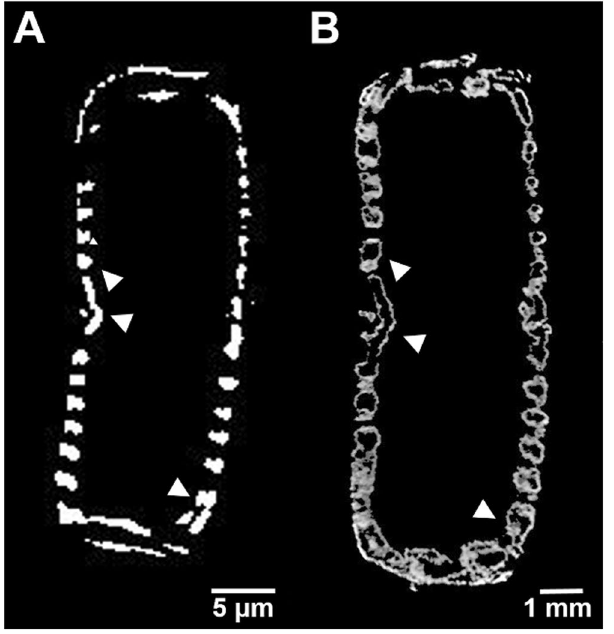
Figure 7. ( A ) Nano-XCT and ( B ) micro-XCT results of cross-sections of self-similar ( A ) natural and ( B ) printed objects based on the design of the frustule of D. geminata (arrowheads: ribs). Scaling up the frustule causes different scale bars.